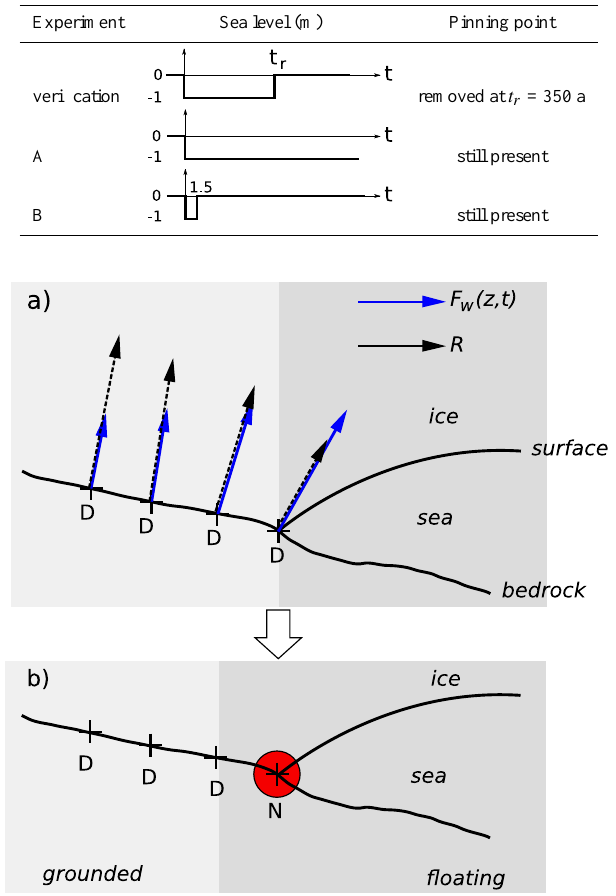
Table 2. Flowchart of the experiments carried out and their charac- teristics.